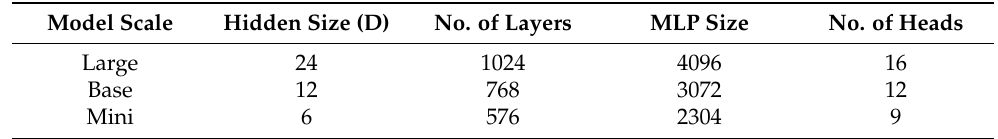
Table 1. Hyperparameters of Large, Base, and Mini Trans U-Net variants. Model Scale Hidden Size